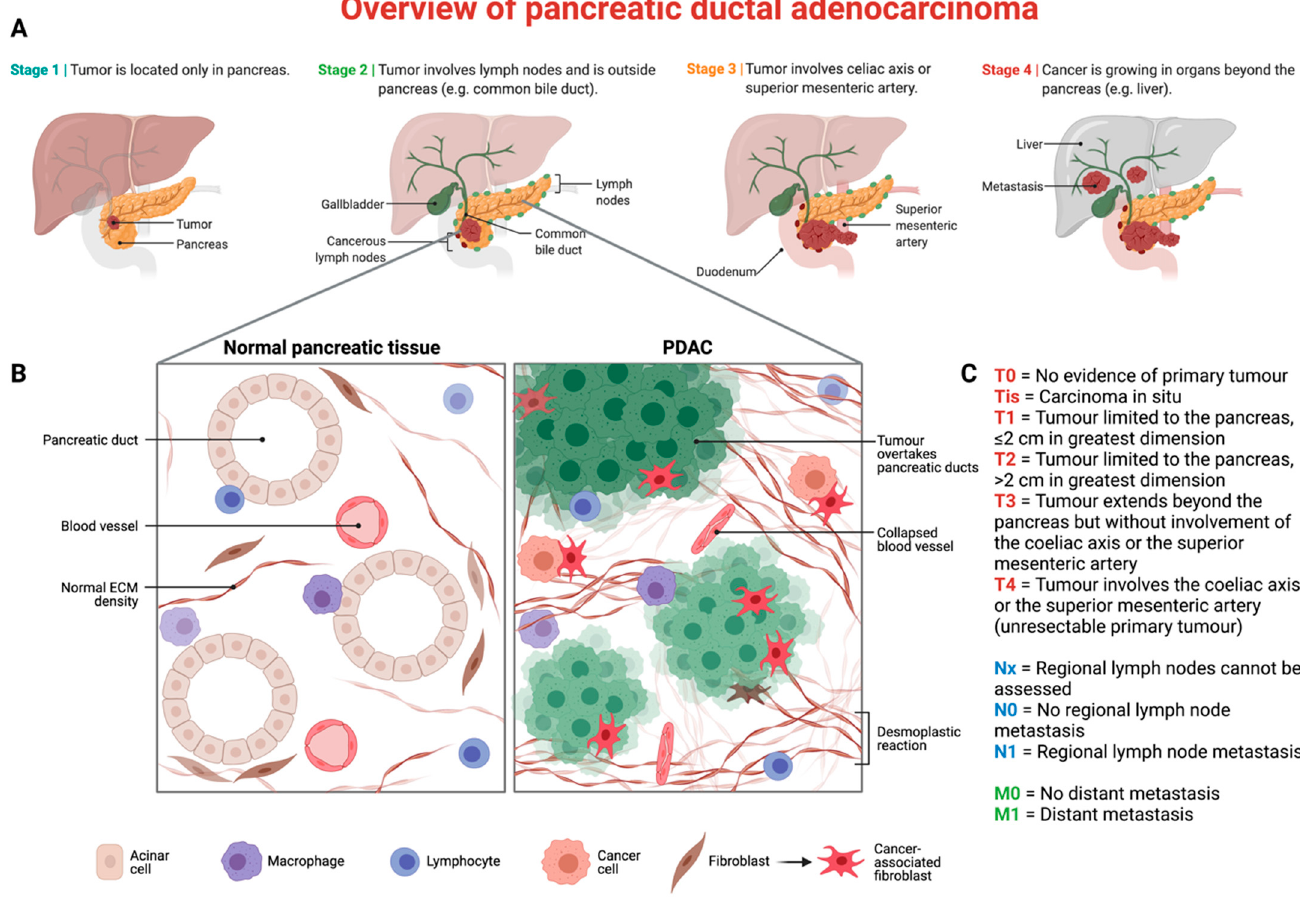
Figure 1. Overview of pancreatic ductal adenocarcinoma (PDAC): tumor microenvironment and classification. ( A ) Stages of PDAC’s progression, according to the AJCC’s 8th edition [21]. ( B ) Mor- phological differences between normal ( left ) and malignant ( right ) pancreatic tissue. ( C ) TNM clas- sification of PDAC.